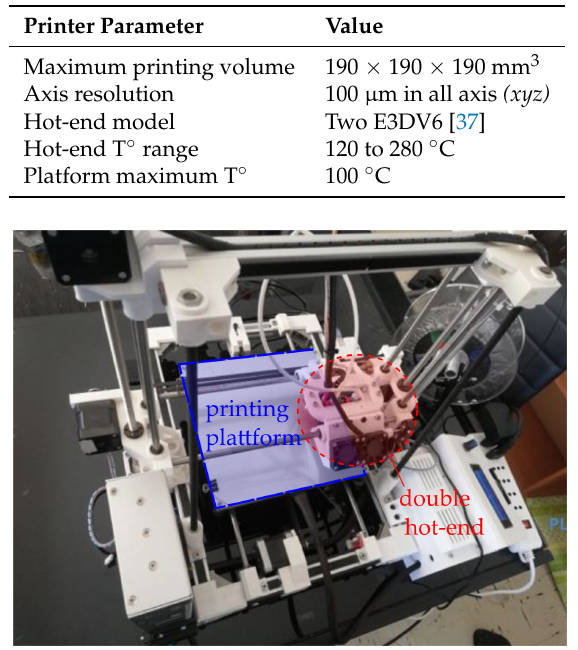
Figure 2. EIE-custom 3D-printer by Ocular3D